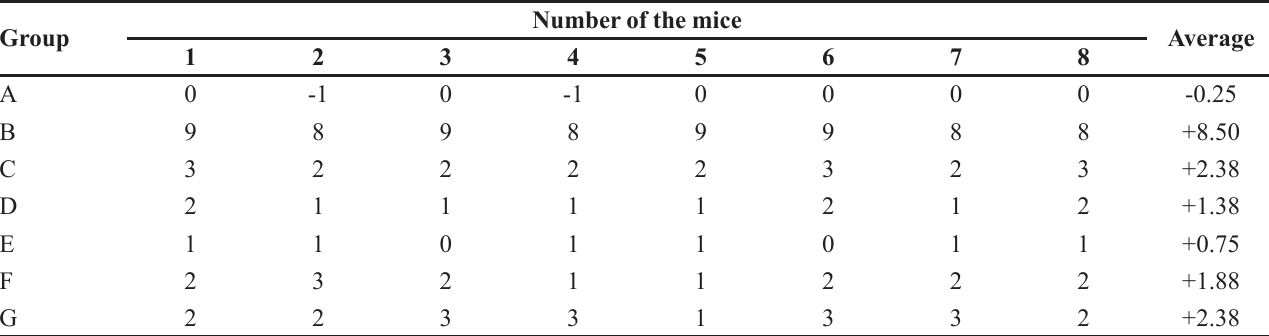
TABLE 4 - Blind scores of the liver injury in different section of mice by pathologists